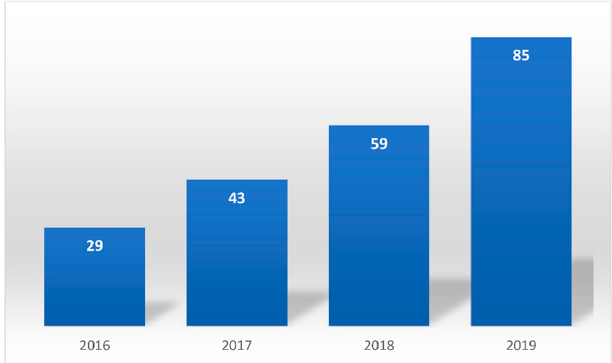
Figure 2. Number of relevant scientific publications according to the SCOPUS database.